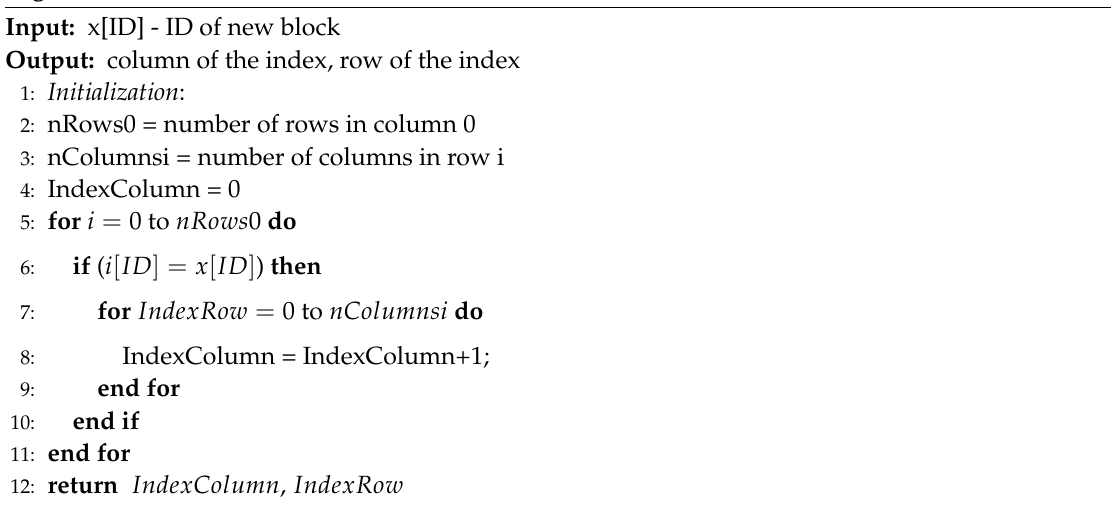
Algorithm 1 Pseudo code to add a block to the Block